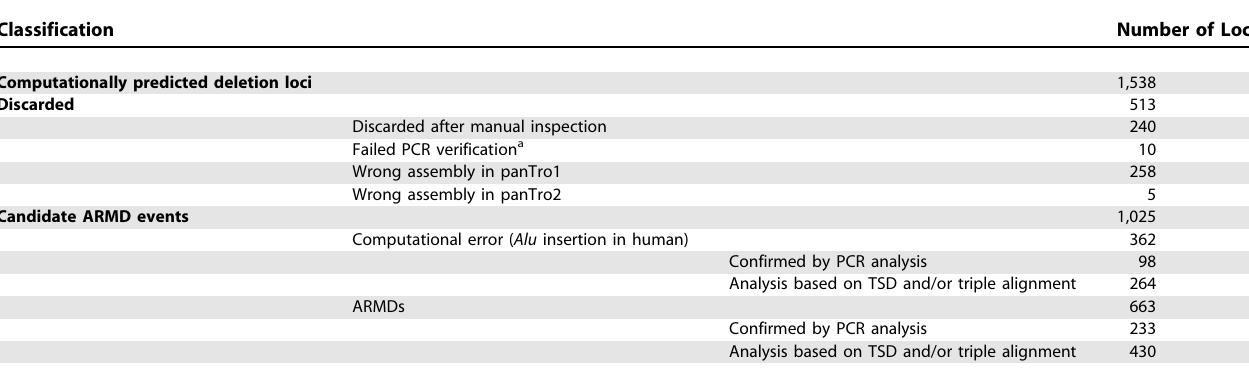
Table 1. Summary of Chimpanzee-Specific ARMD